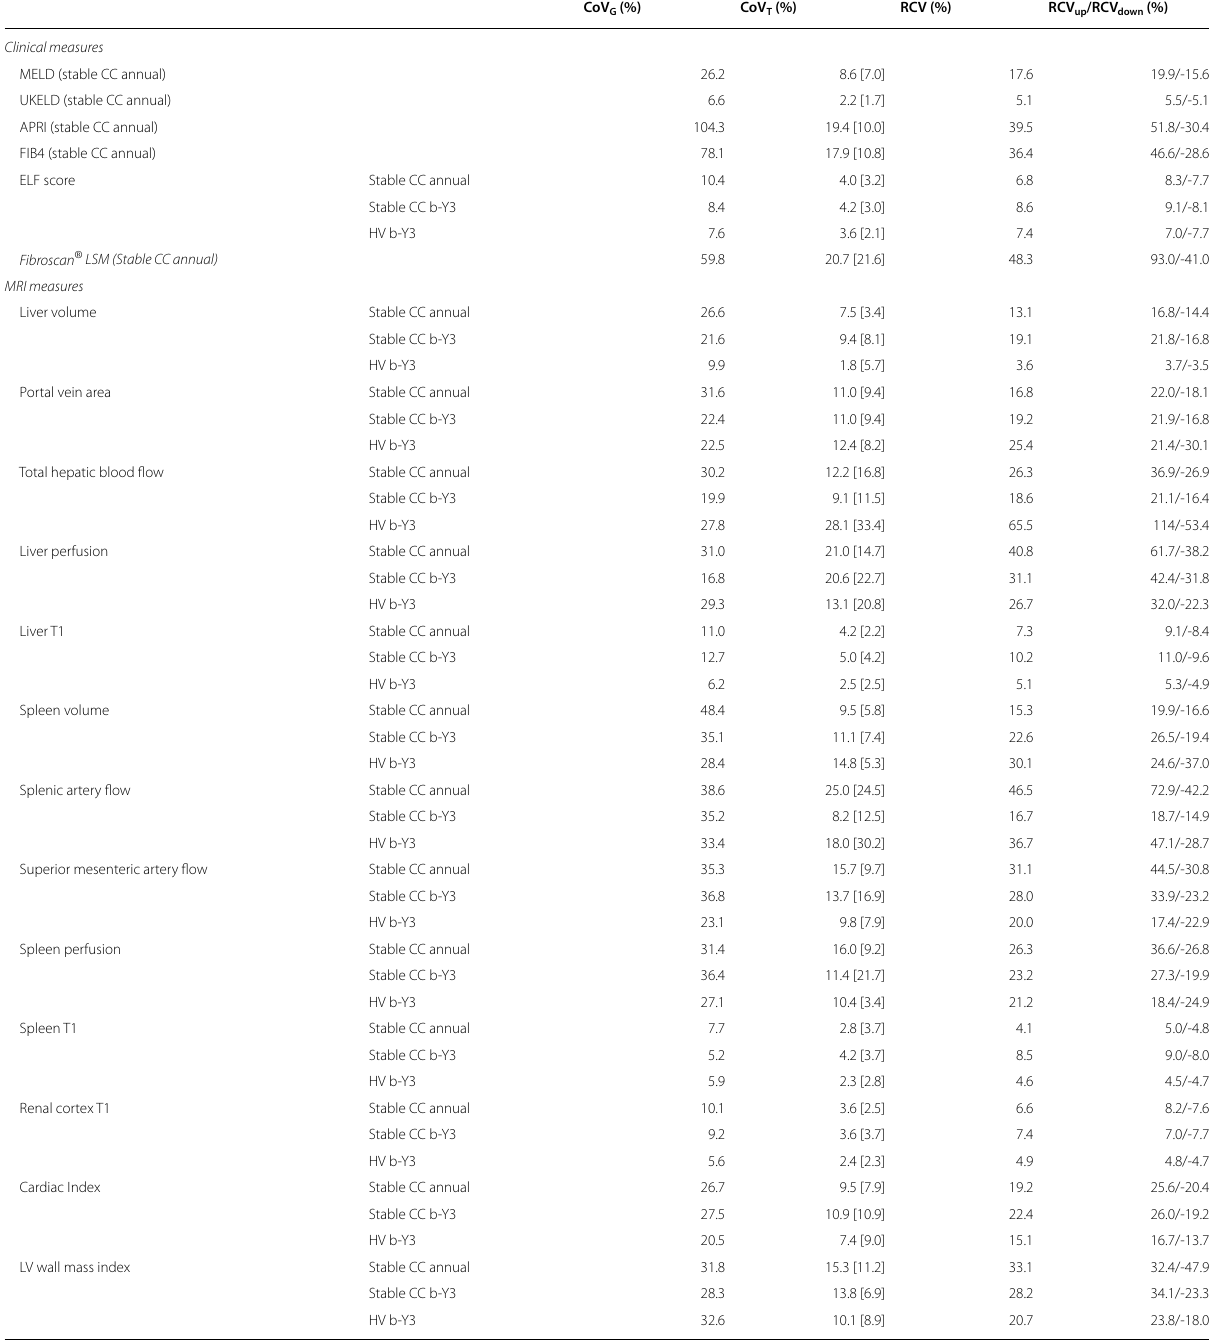
Table 3 Interindividual baseline variance (CoV asymmetrical limits of the log-normal RCV (RCV and magnetic resonance imaging (MRI)